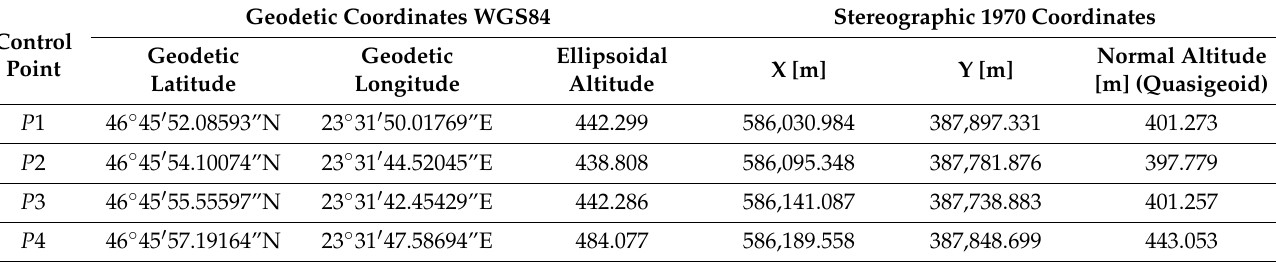
Table 1. Obtained control point coordinates.